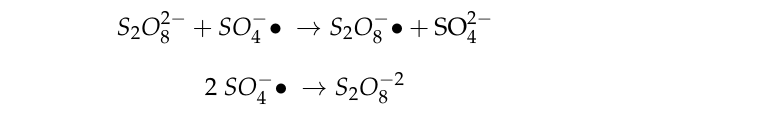
Figure 4. Effect of PS concentration in ( a ) conversion of the NAP; ( b ) conversion of PS at 30 min and 180 min. 𝐶 NAP,0 = 0.1 mM,𝐼 = 0.18 W · cm −2 ,𝐶 GOE = 0.1 g · L −1 · cm 2 and 25 ℃.